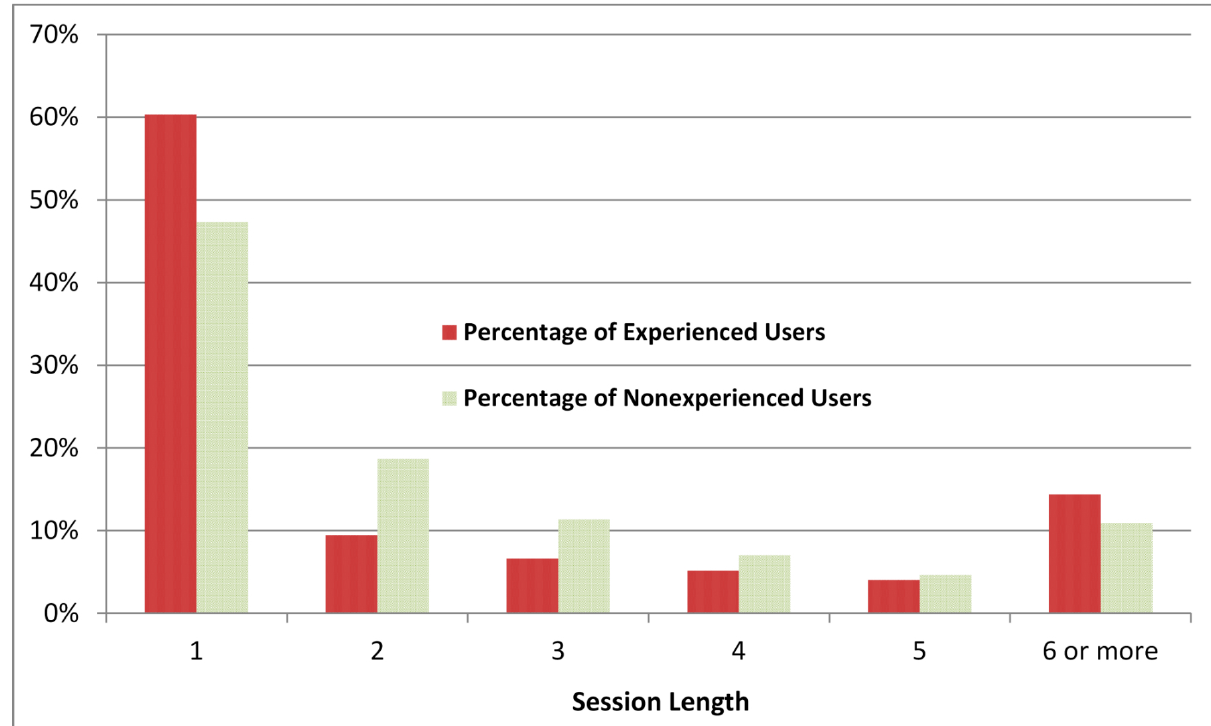
Figure 5. Percentages of experienced and nonexperienced users per session length (# of queries per